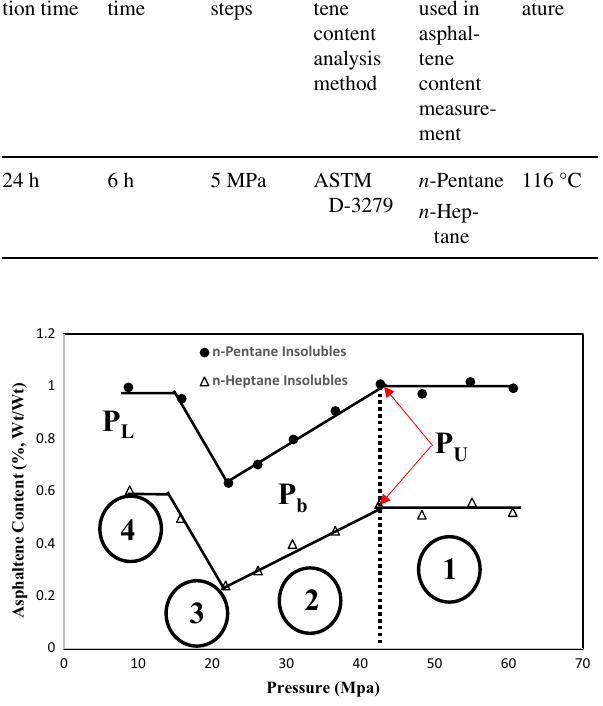
Fig. 3 Schematic representation of pressure depletion process for AOP measurement using gravimetric method ( P U , upper pressure boundary; P L , lower pressure boundary; P b , bubble point pressure) Fig. 4 Asphaltene content versus pressure (Jamaluddin et al.